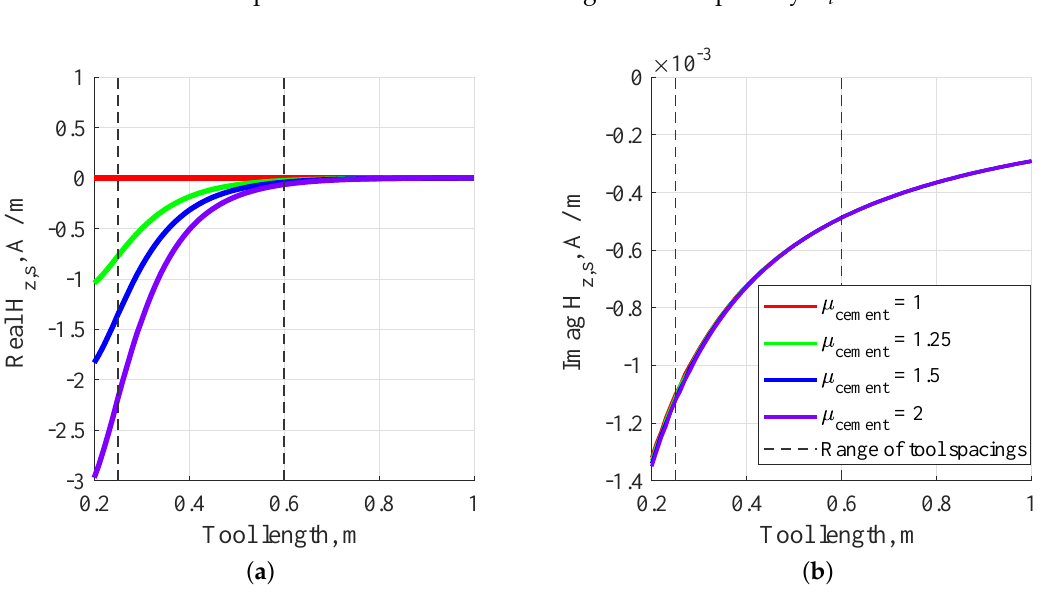
Figure 3. Effect of magnetic permeability of cement on magnetic field at the frequency of 1 kHz: ( a ) Tool length vs. real part of secondary field, H z , s . ( b ) Tool length vs. imaginary part of H z , s